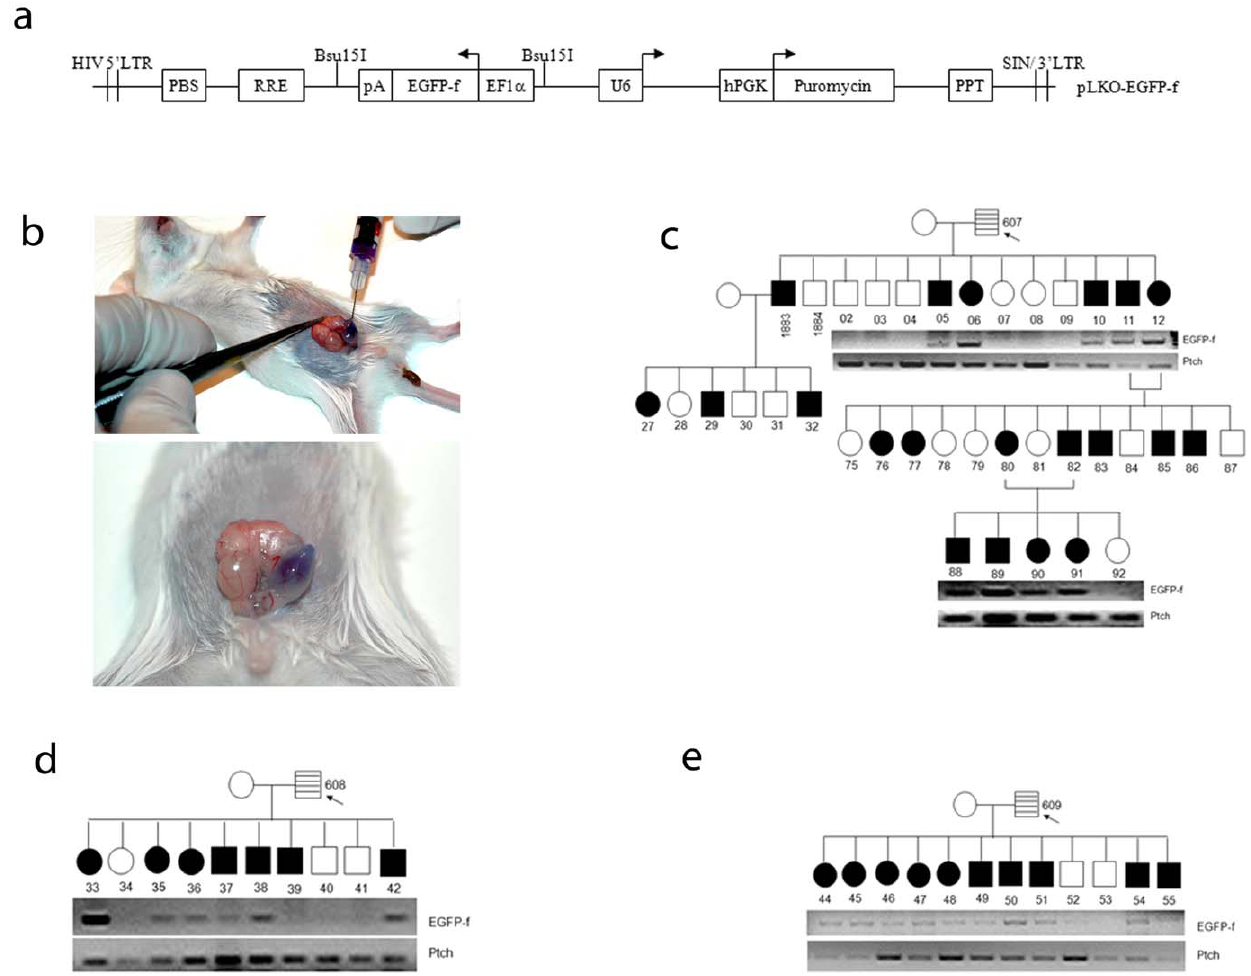
Figure 1. Generation of transgenic mice. A . Design of the vector used for generating transgenic mice. B . Injection of recombinant lentiviruses into mouse testis. C–E . Pedigree analysis for pre-founder mice 607 (c), 608 (d) and 609 (e) showing germline transmission of the transgene. Individual mice were assigned numbers for further experiments. Genomic DNA amplification using primers for EGFP-f or patch (as a loading control) are shown.